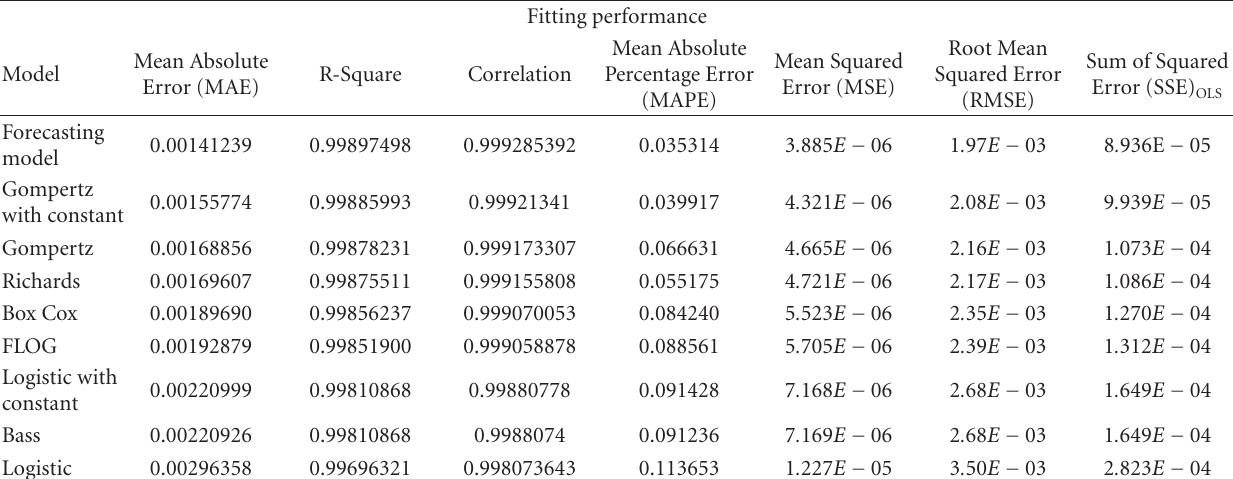
Table 1: Results of the fitting process for the models.